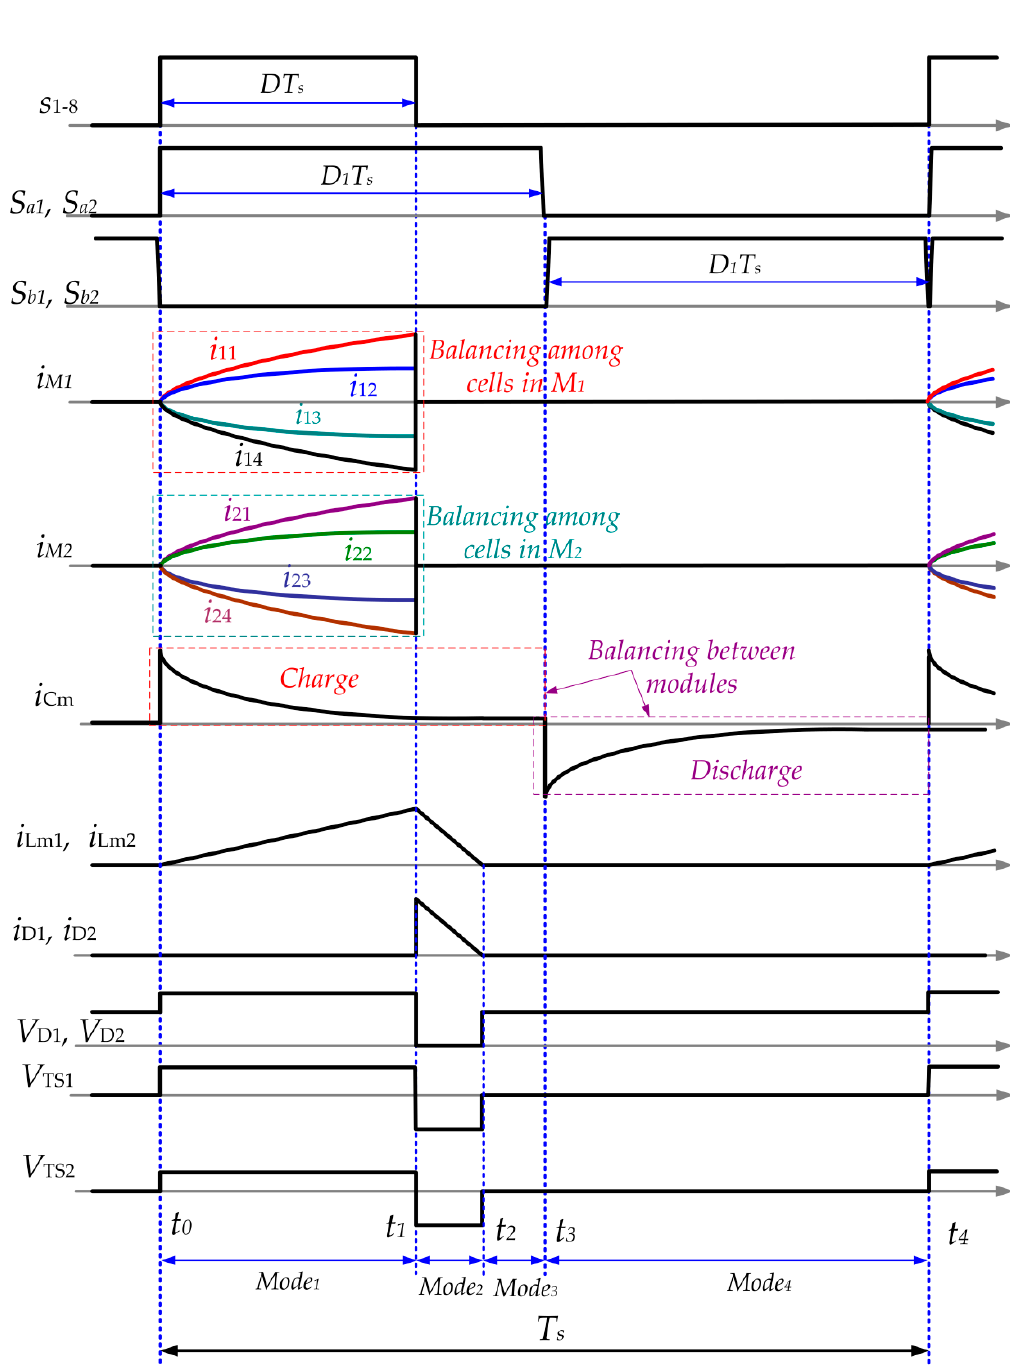
Figure 9. Operational waveforms of the proposed modular cell balancing circuit (MCBC).